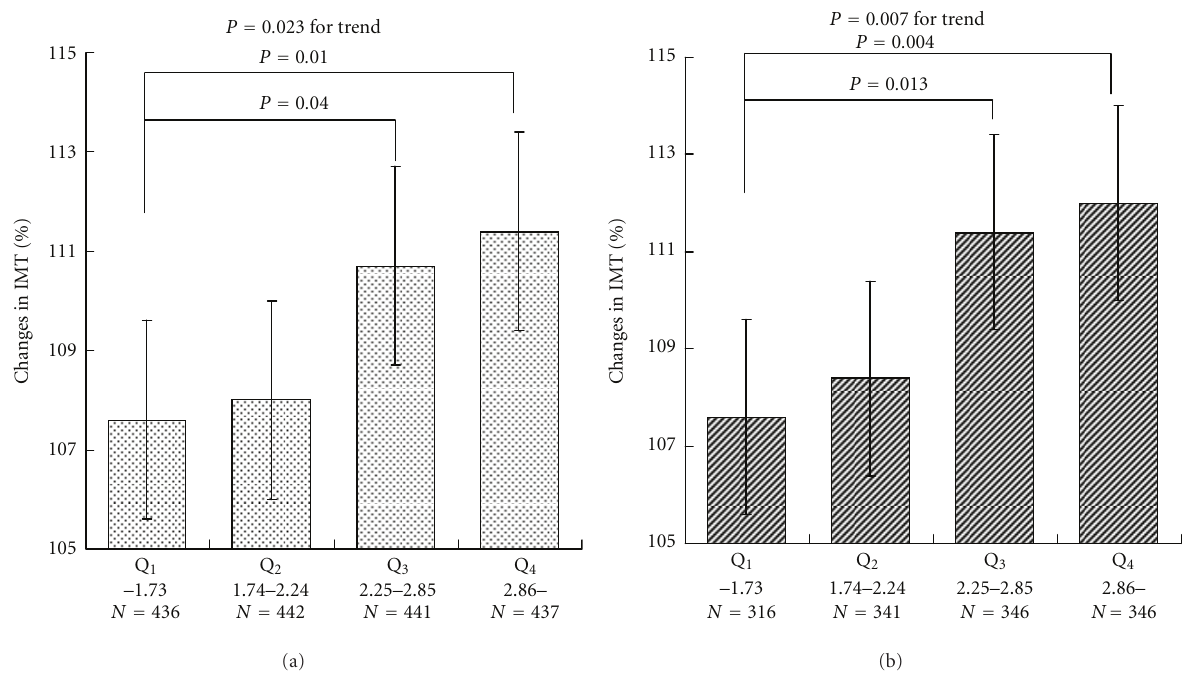
Figure 1: Relationship between LDL-C/HDL-C ratio and changes in IMT. (a) Data from 1,456 subjects was analyzed by ANCOVA adjusted for age, sex, baseline IMT, and lipids lowering medication. (b) Data from 1,349 subjects with less than 1.1 mm IMT at baseline was analyzed by ANCOVA adjusted for age, sex, baseline IMT, and lipid lowering